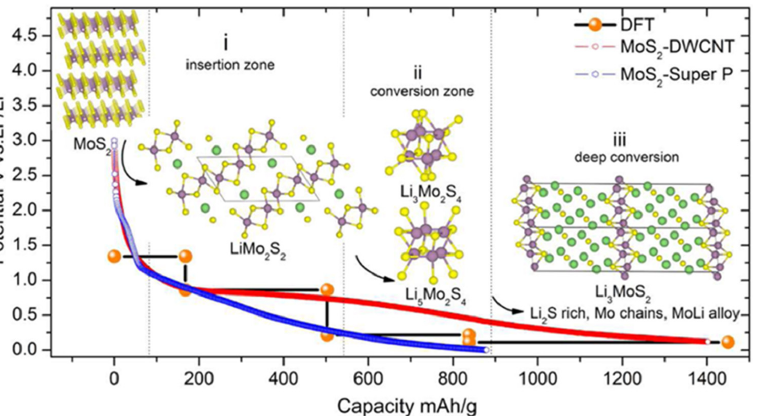
Figure 4. Li-ion transport mechanism of the MoS 2 structure in lithium-ion batteries. Reprinted (adapted) with permission from Reference [112], Copyright (2016), American Chemical Society.